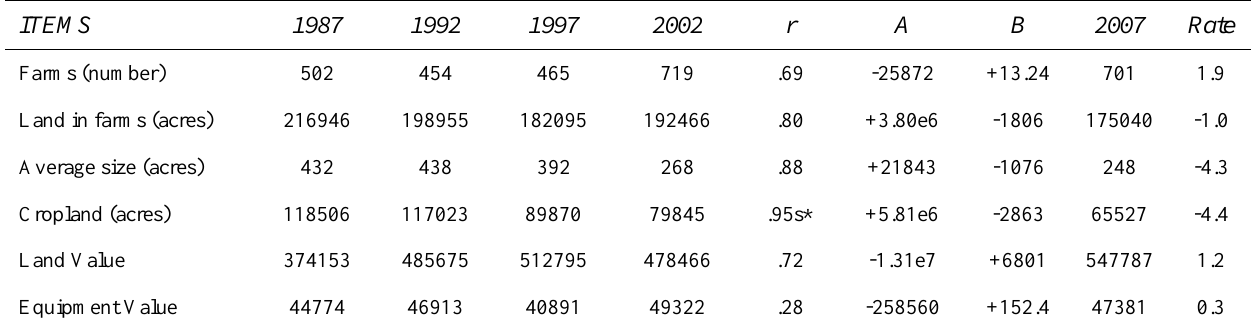
Table 2e: Madison County Regression Analysis